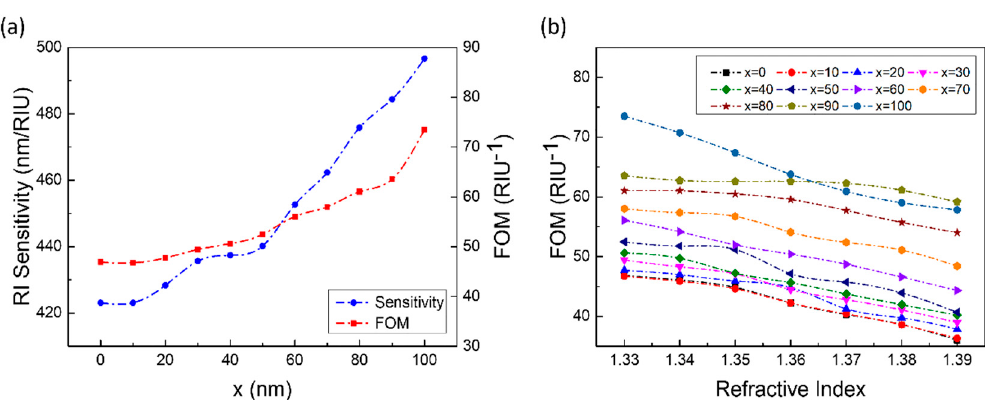
Figure 9. The influence of the distance between the center of a circular hole and a circular disk on the sensing performances. ( a ) The sensitivity and FOM ( n = 1.33) changes with x . ( b ) The impact of x changes on FOM when n = 1.33–1.39. (The dashed line connecting the data points is simply connected with a smooth curve for readers as a guide for an eye.).